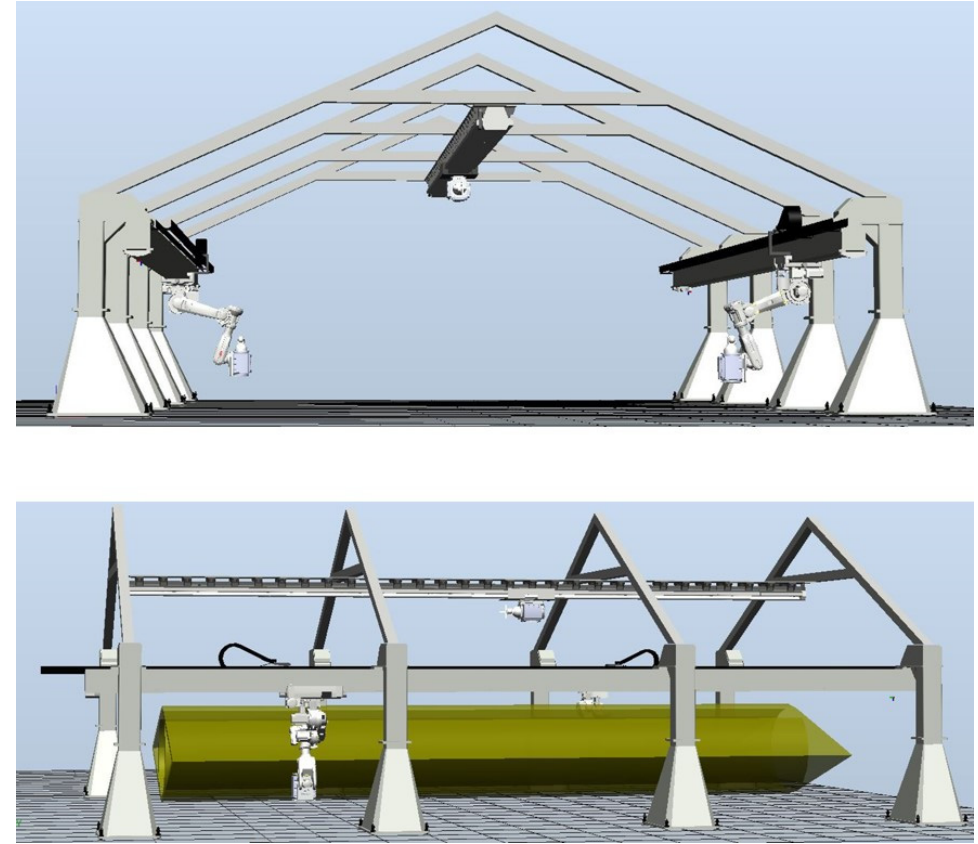
Figure 2. Early concept illustration of an automated large-volume dimensional measuring system. Two robots mounted on linear guides carrying one laser sensor each together with one overhead linear guide carrying one laser radar sensor. Measuring volume: 14 × 10 × 4 m 3 .